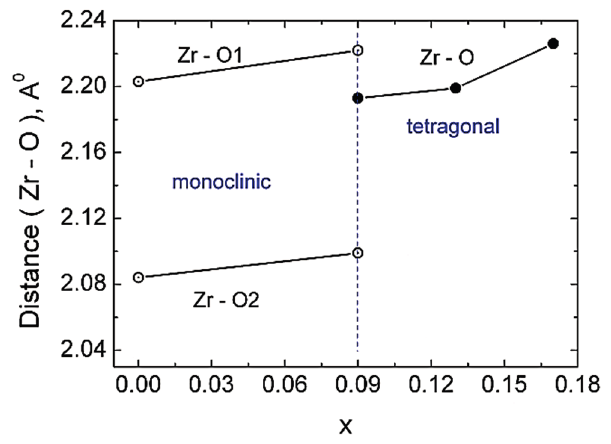
Figure 6. The dependence of Zr-O distances vs. the Ce concentration ( x ).